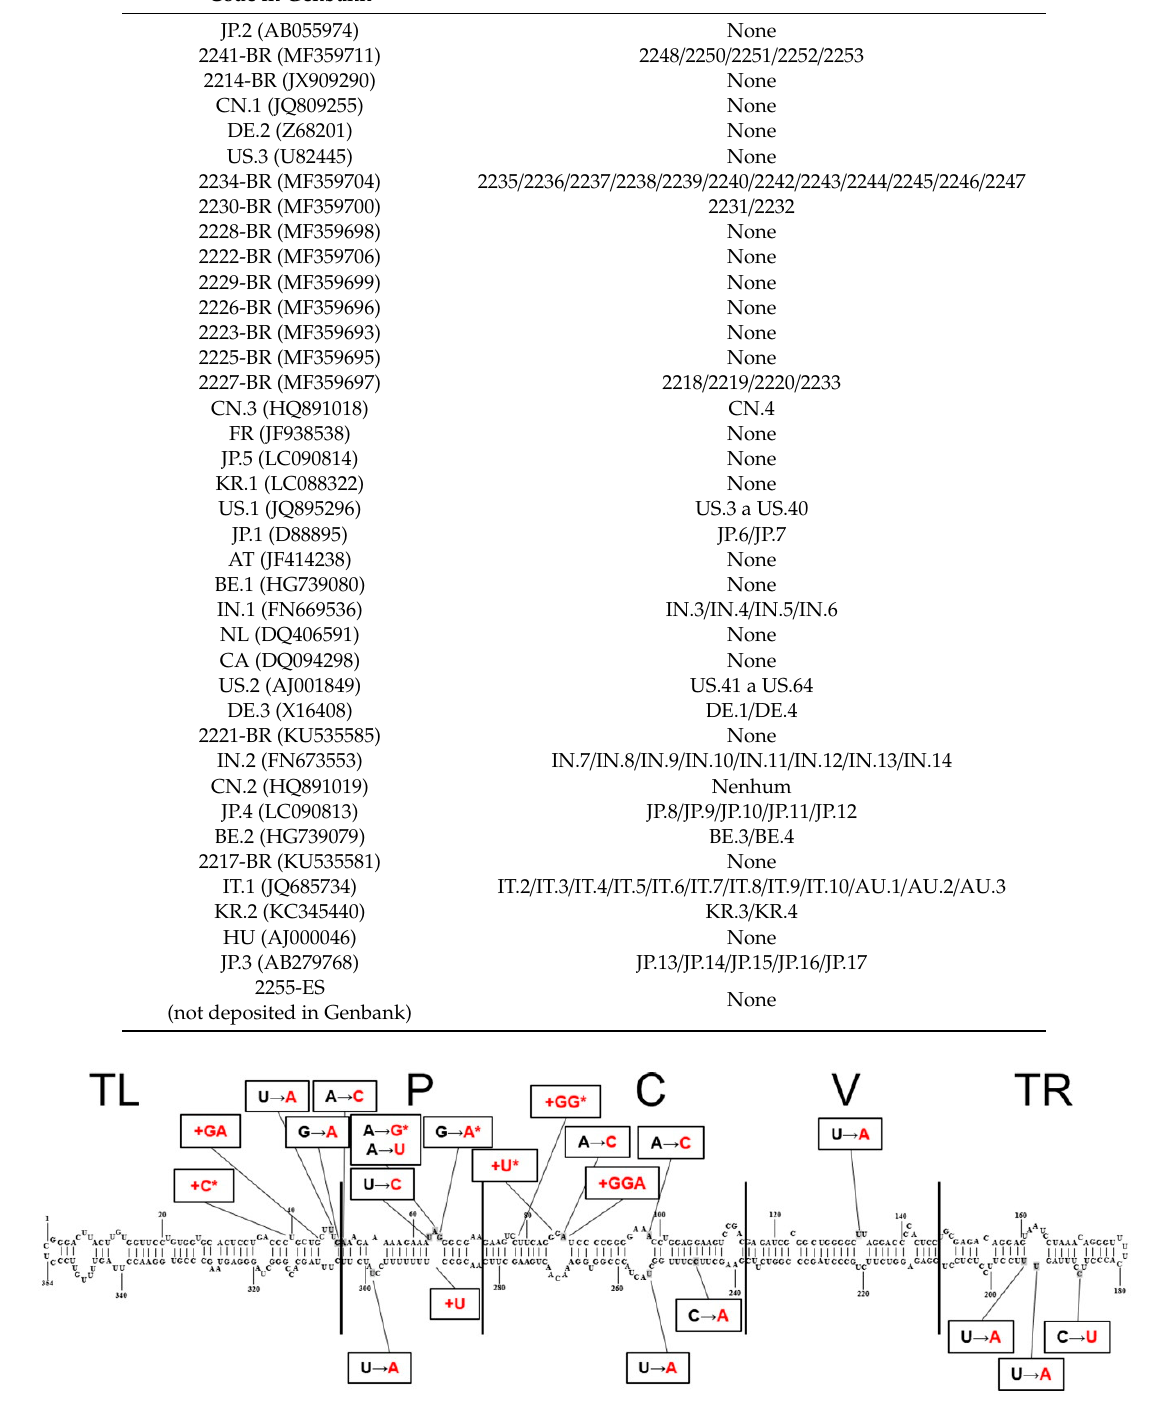
Figure 4. Predicted secondary structure of chrysanthemum stunt viroid (CSVd) Brazilian isolate 2214 (Genbank number JX909290) [8]. Changes ( → ) and insertions ( + ) in the residues among all Brazilian and Colombian CSVd variants were shown in the boxes. Changes observed in the Colombian variants were indicated with asterisks. The five domains of pospiviroids are marked: terminal left and right (TL and TR), pathogenicity (P), central conserved (C) and variable (V).